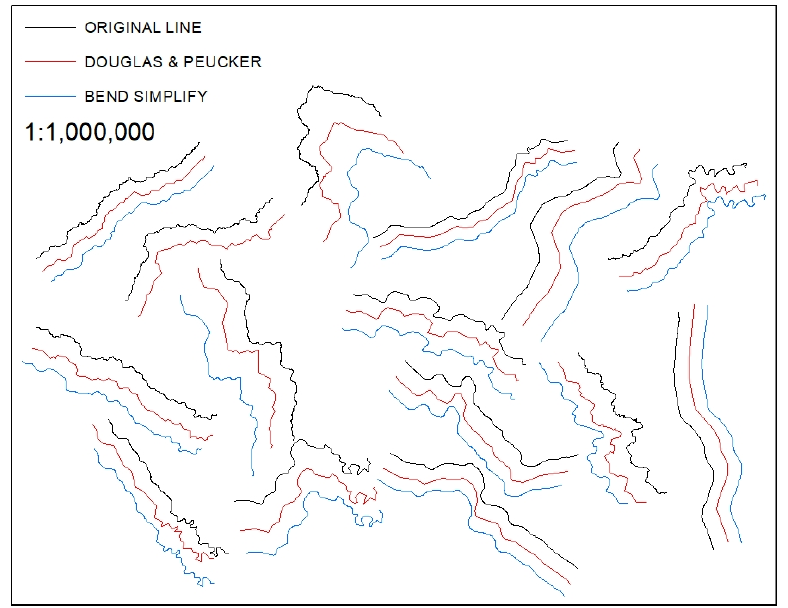
ISPRS Int. J. Geo-Inf. 2022 , 11 , x FOR PEER REVIEW 16 of 22 Figure 6. Line features generalized with the Douglas–Peucker simplification algorithm (red) and bend simplification algorithm (blue). Original lines are depicted in black (scale 1:1,000,000).